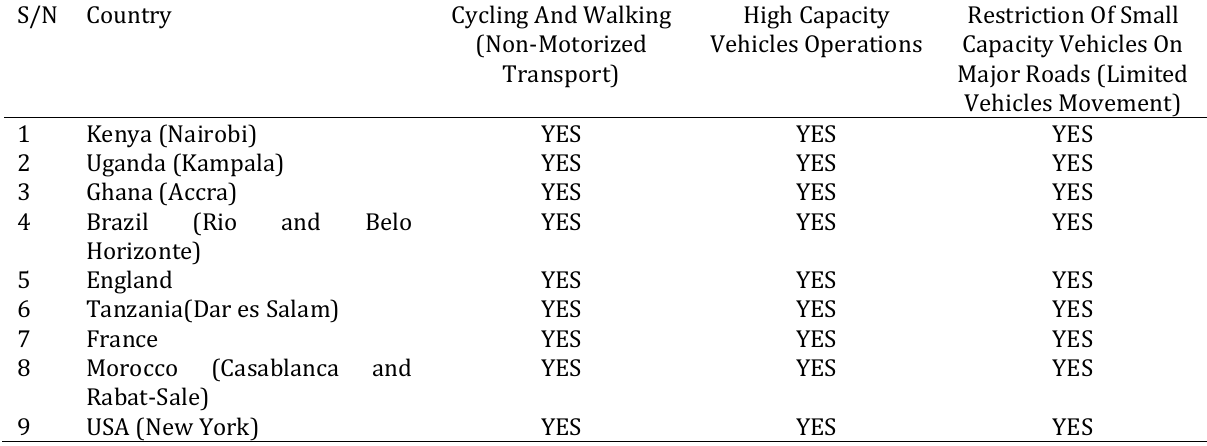
Table 1: Comparism of sustainable urban mobility of some selected countries S/N Country Cycling And Walking (Non-Motorized